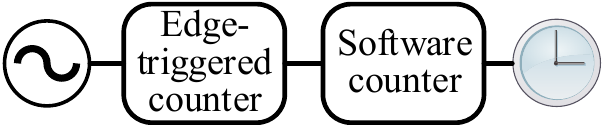
Figure 4. An implementation of a